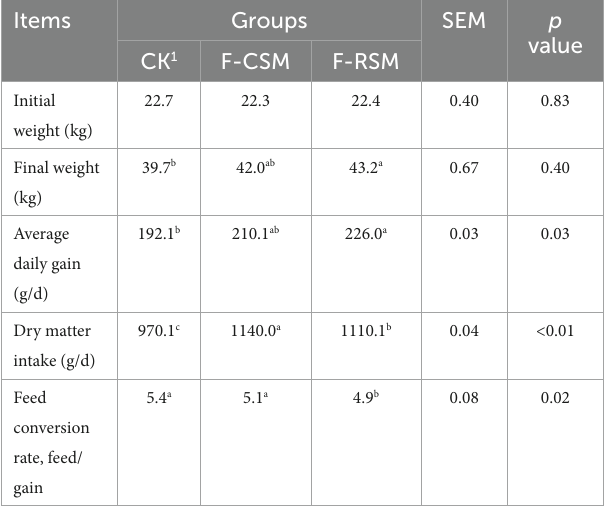
TABLE 2 Effects of the diets on growth performance of Hu sheep.